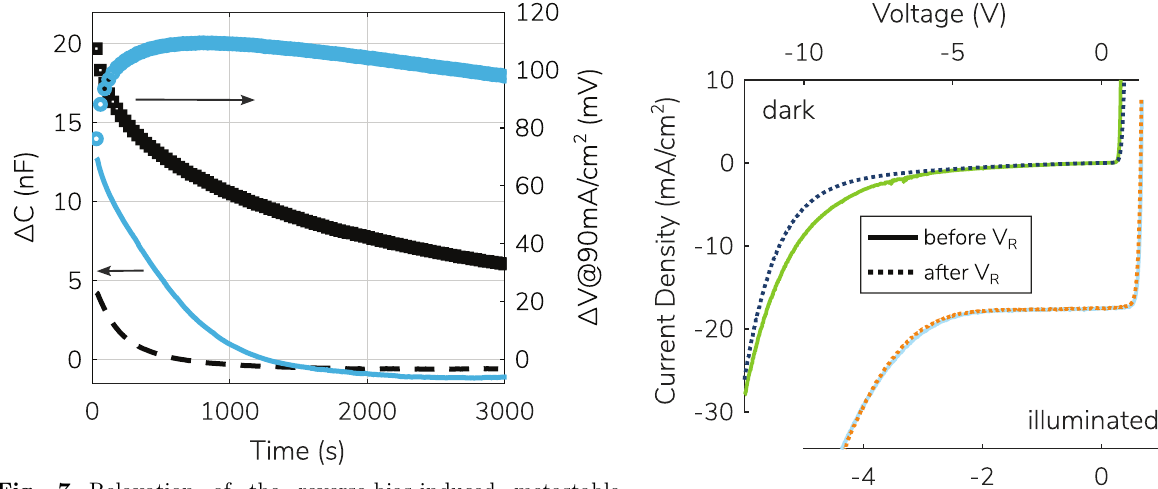
Fig. 7. Relaxation of the reverse-bias-induced metastable changes of the capacitance (lines, left vertical axis) and of the IV shift (symbols, right vertical axis) after continuous (blue) and intermittent (black) reverse-bias treatments of 600 s.